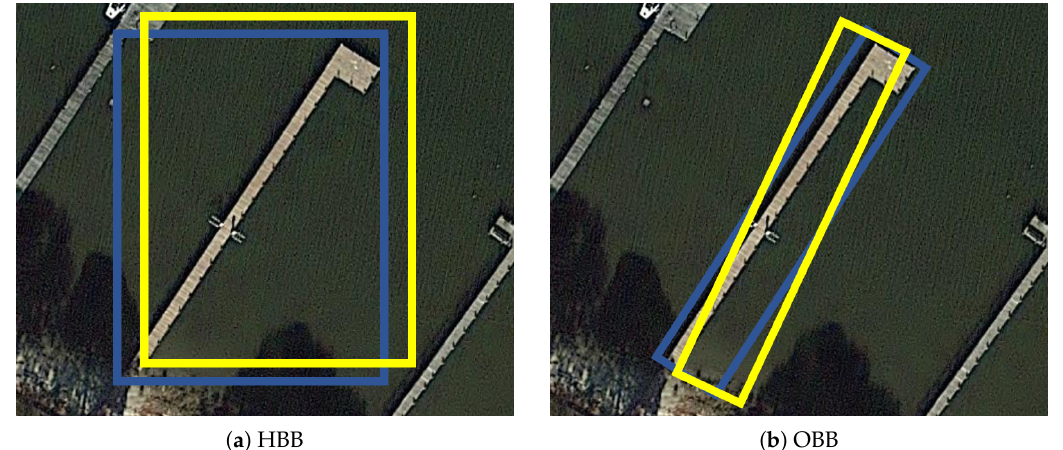
Figure 6. Example of bounding box prediction on HBB ( a ) and OBB ( b ). Ground truth bounding boxes are denoted by blue, while predicted bounding boxes are colored by yellow. Only the centre target are labelled for